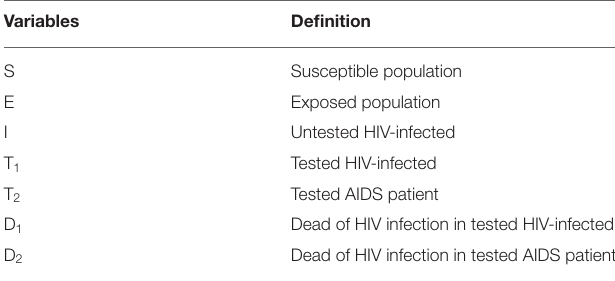
TABLE 1 | Variables and definition of the structure of the HIV transmission dynamics model.